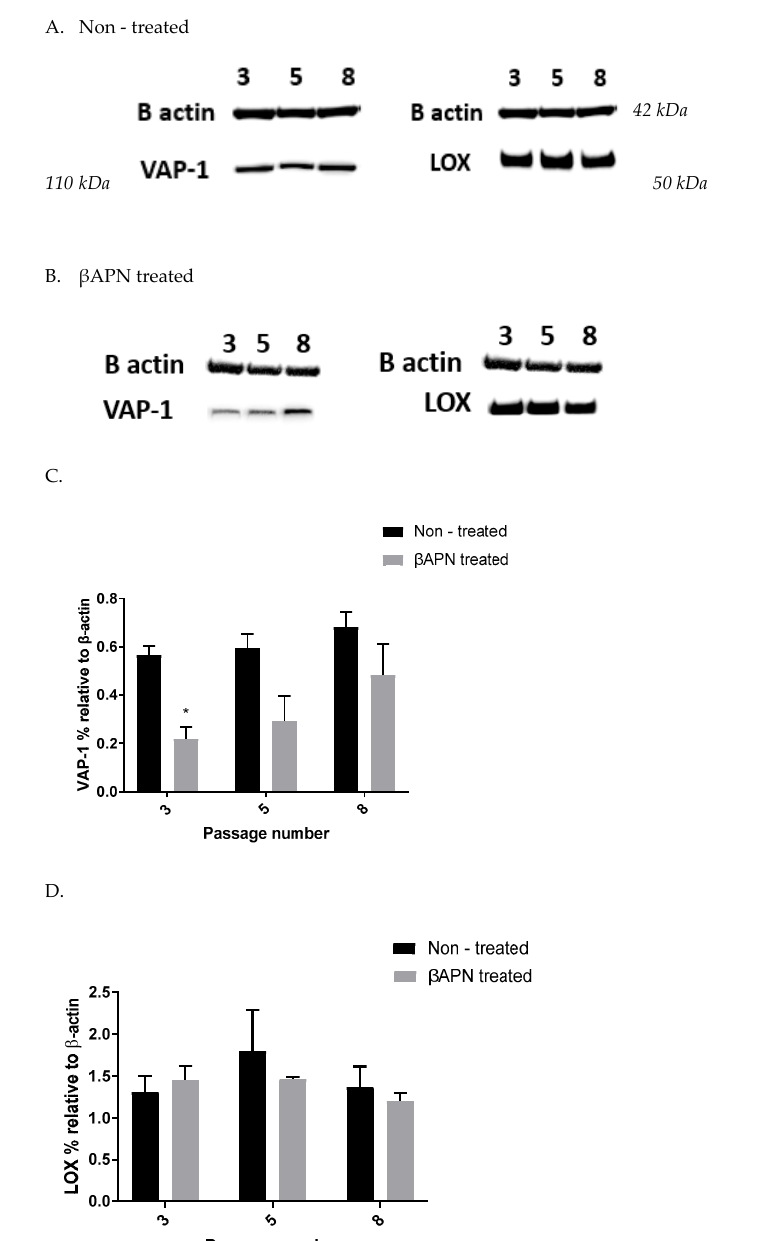
Figure 3. VAP-1 and LOX protein expression in non-treated VSMCs from passages 3, 5, and 8 ( A ) and after 1 h β APN treatment ( B ). VAP-1 expression (expressed as percentage relative to β -actin) in non-treated (control: black bars) and β APN treated (grey bars) rat aortic VSMCs from passages 3, 5, and 8 ( C ). There was no significant difference in VAP-1 expression over passage ( p > 0.05). At passage 3, * p < 0.05 for β APN treated vs. non-treated cells. LOX expression (expressed as percentage relative to β -actin) in non-treated (control: black bars) and β APN treated (grey bars) rat aortic VSMCs from passages 3, 5, and 8 ( D ). There was no significant difference in LOX expression over passage, or between non-treated vs. β APN treated cells ( p > 0.05). Values are mean ± S.E.M. (n =